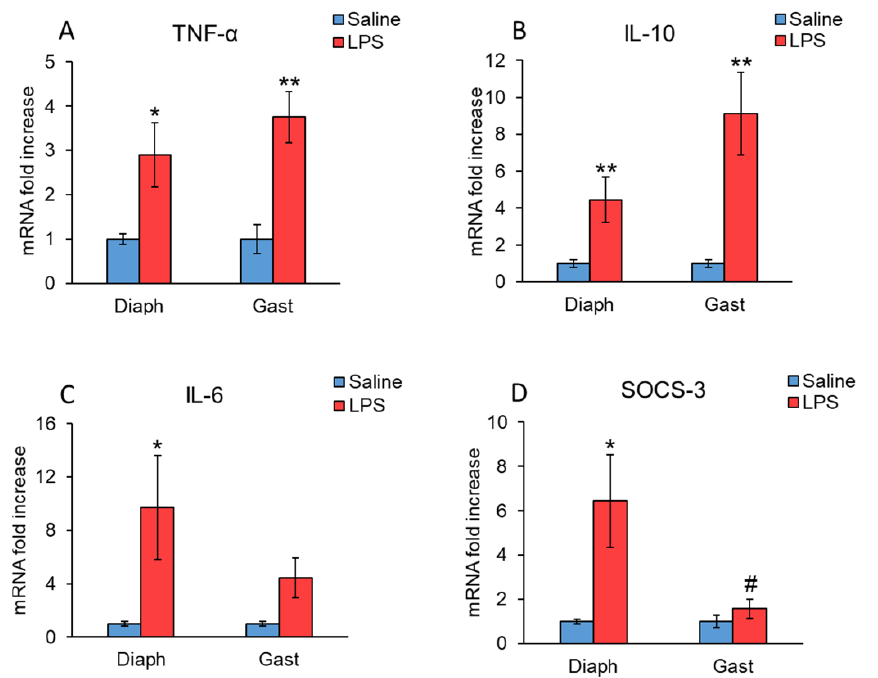
Figure 2. Effect of sepsis induced by LPS injection (10 mg/kg ip.) on ( A ) TNF α , ( B ) IL-10, ( C ) IL-6 and ( D ) SOCS3 mRNA, in rat diaphragm and gastrocnemius muscles, 24 h after a single injection of LPS or saline solution. mRNA was measured by PCR. Data represent mean ± standard error of the mean (SEM) for n = 7–8 rats/group. * p < 0.05 and ** p < 0.01 versus their respective control rats treated with saline, # p < 0.05 versus diaphragm of rats treated with LPS. Diaph: diaphragm, Gast: gastrocnemius.